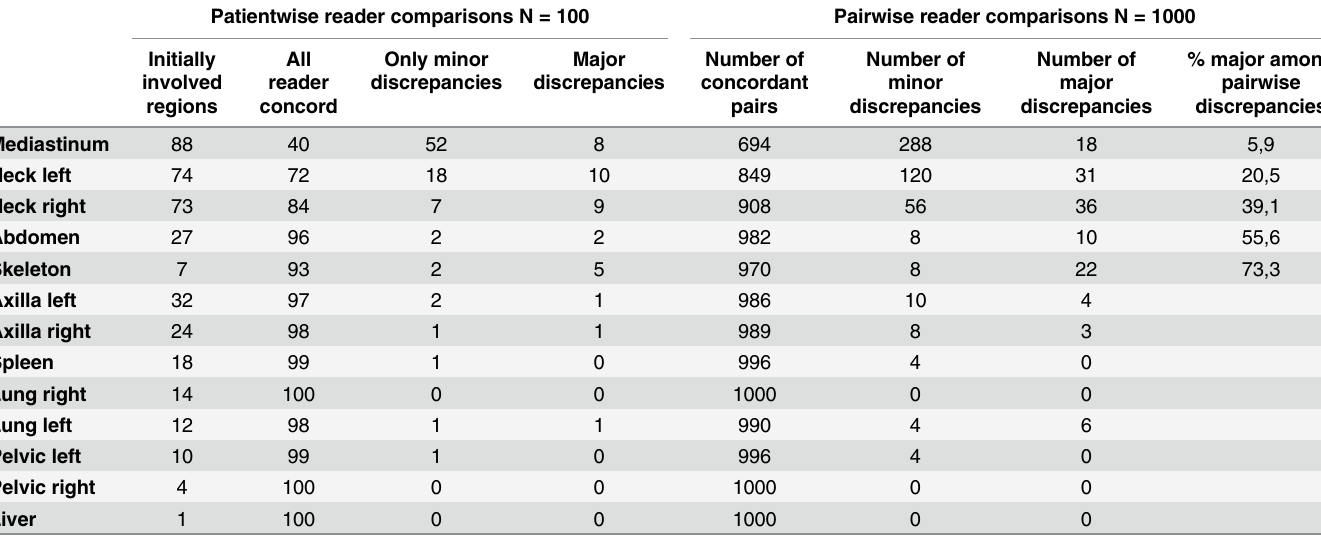
Table 3. Discrepancy analysis by region using the D1,2 vs D3 vs D4,5 three category scale. Patientwise reader comparisons N =